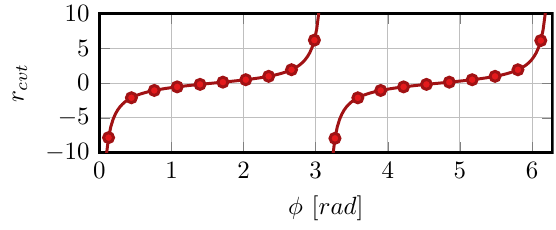
Figure 2. The complete transmission ratio range of the